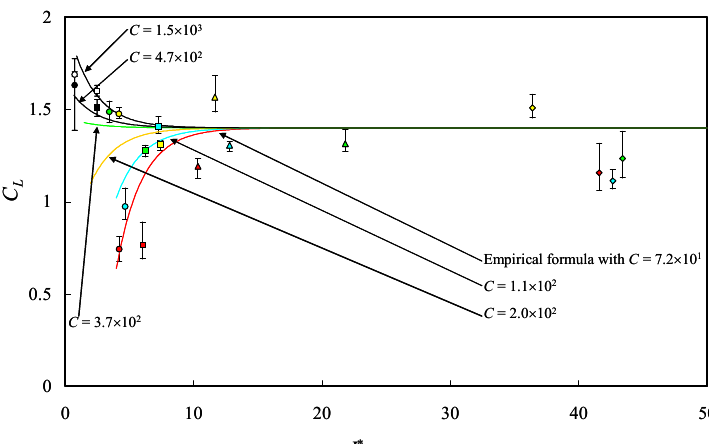
Fig. 7 Lift coefficient C L versus inertia moment ratio I * , for λ = 0.3, AR = 10, C = 7.2 × 10 1 − 1.6 × 10 3 and I * = 0.75 − 43. Empirical formula is described as Eq. (21).